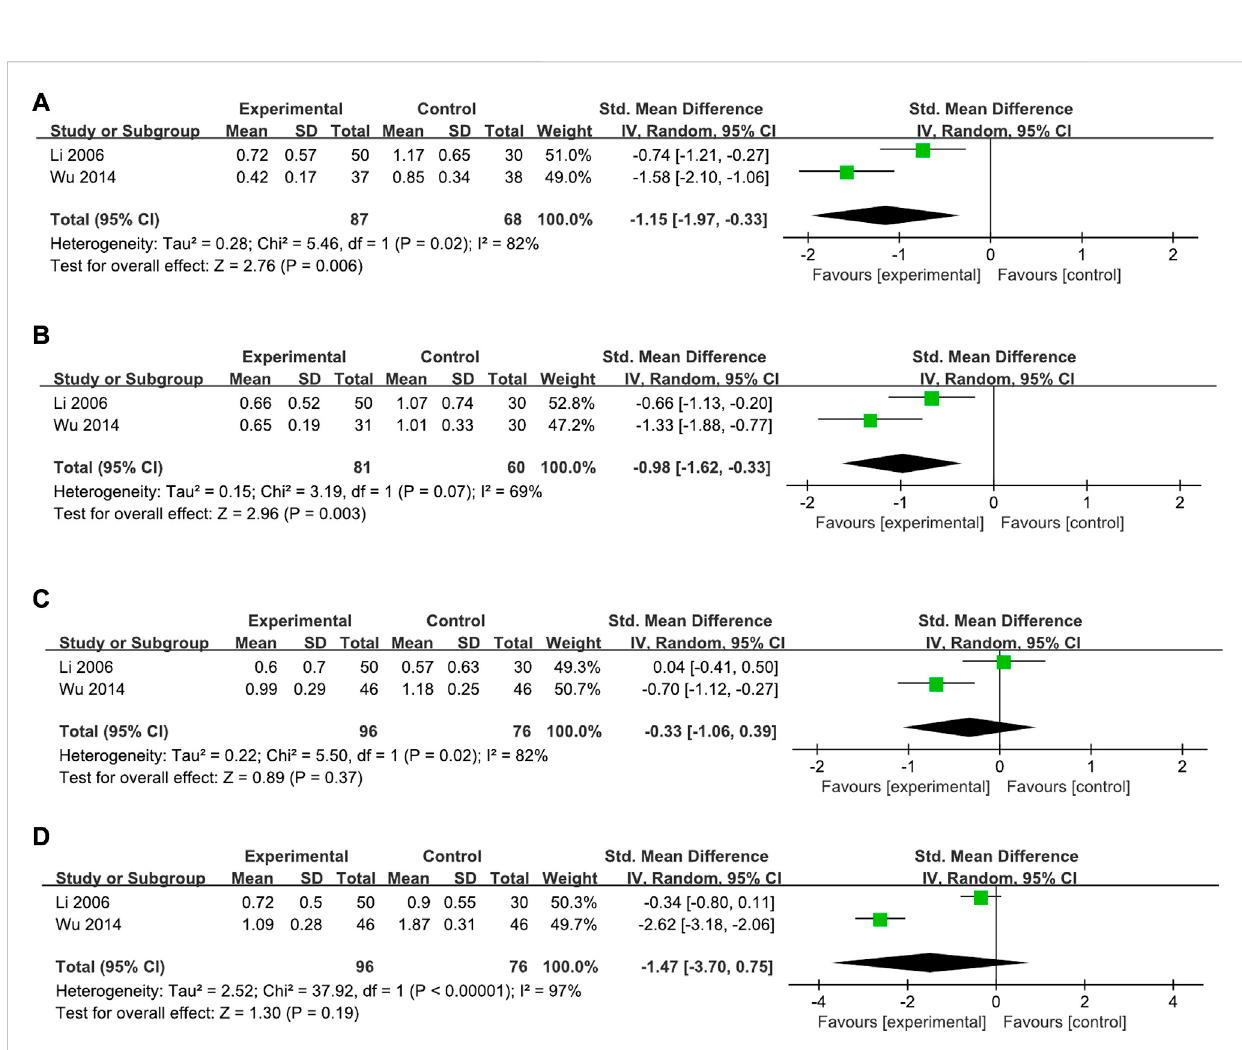
FIGURE 6 Forest plot of the comparison for the scores of speci fi c dyspeptic symptoms between the XYS and WM groups. (A) Abdominal distension; (B) upper abdominal pain; (C) belching; and (D) early satiety.